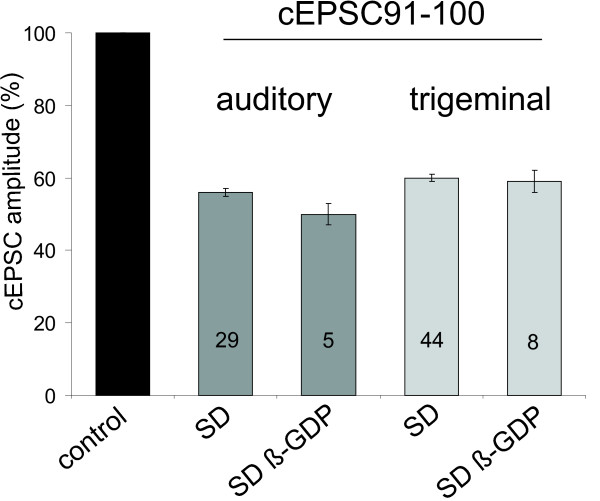
Postsynaptic G-protein inactivation does not inhibit synaptic depression. 100 bursts were applied to auditory or trigeminal afferent fibers. Compared to cEPSC1 (control), the burst sequences induced synaptic depression to about 60 % of initial amplitude (SD). This was also true for giant neurons that had been perfused with β-GDP using the patch pipette (SD β-GDP). cEPSC 91–100 were averaged for each cell, the number of cells is indicated for each group. Error bars indicate the standard error between cells.